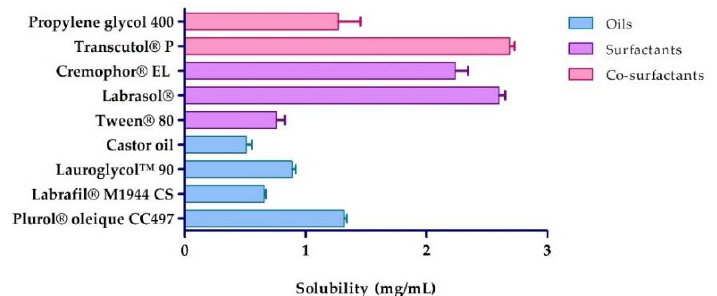
Table 1. Formula of apremilast microemulsion (APR-ME). Figure 2. Apremilast solubility in di ff erent vehicles ( n = 3). Figure 2. Apremilast solubility in different vehicles (n = 3).